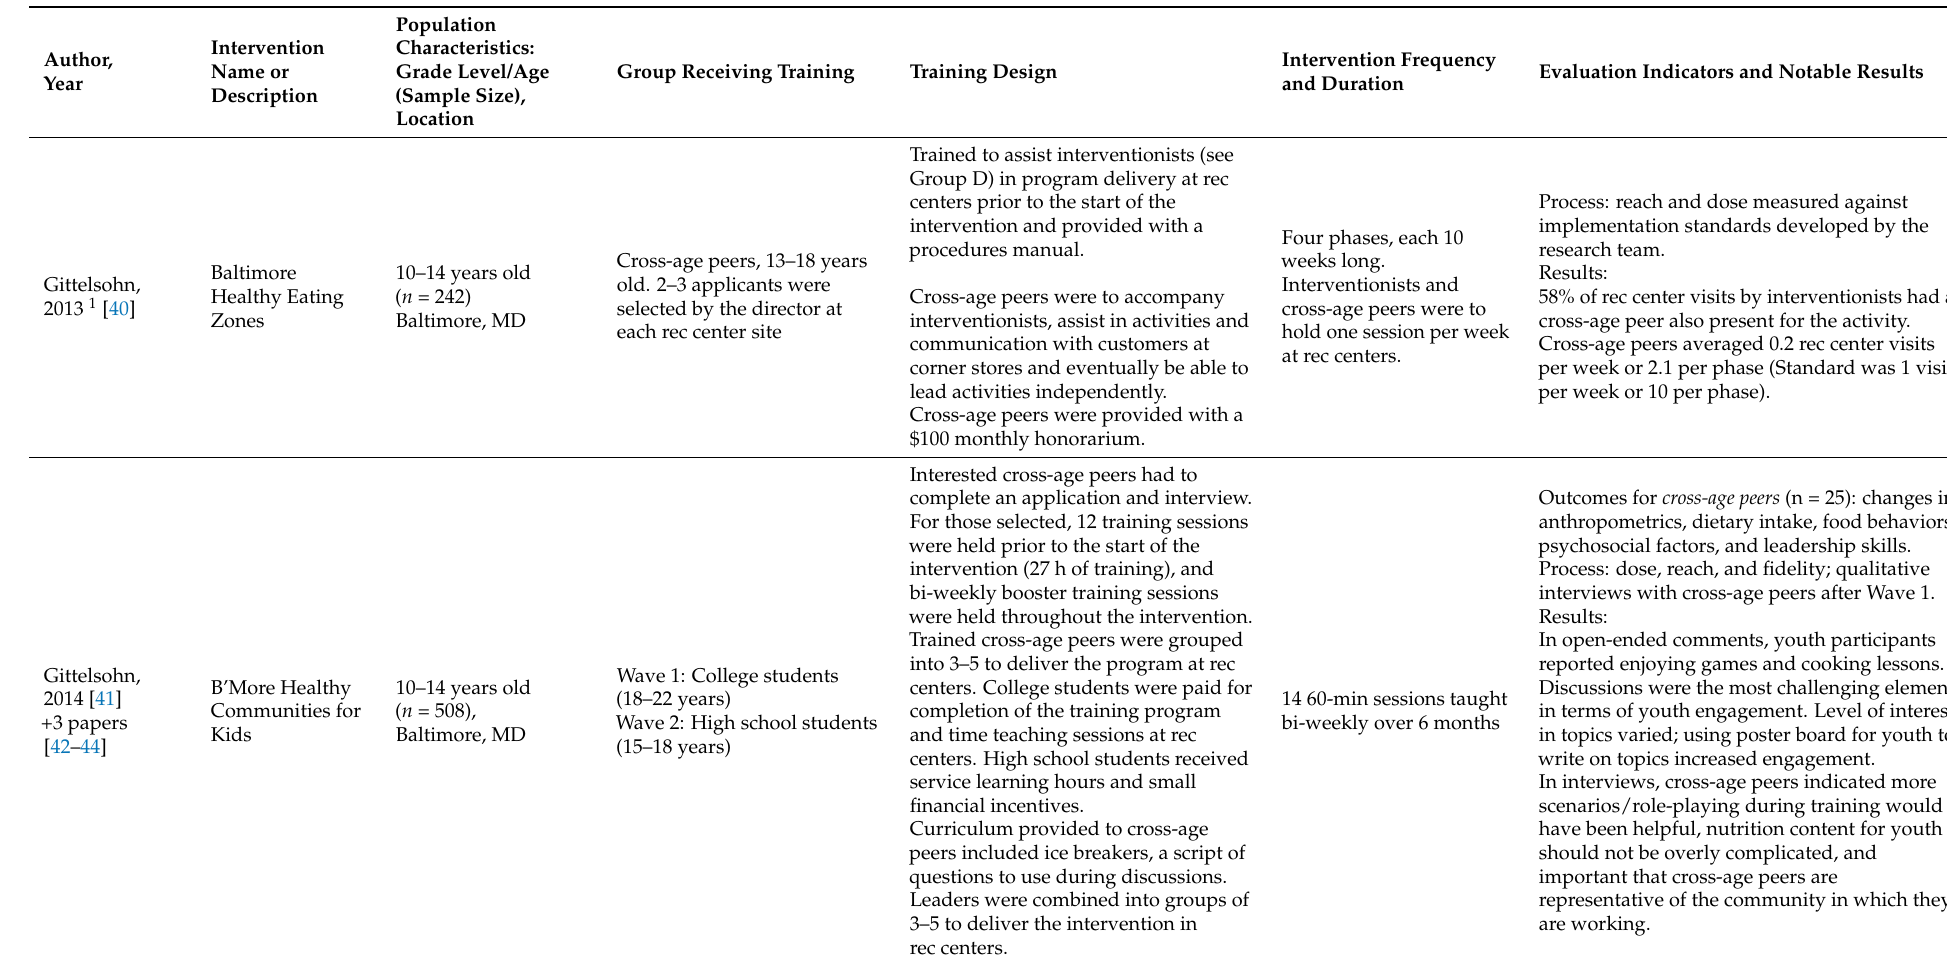
Table 6. Group E: Community, afterschool, or extracurricular interventions that trained cross-age